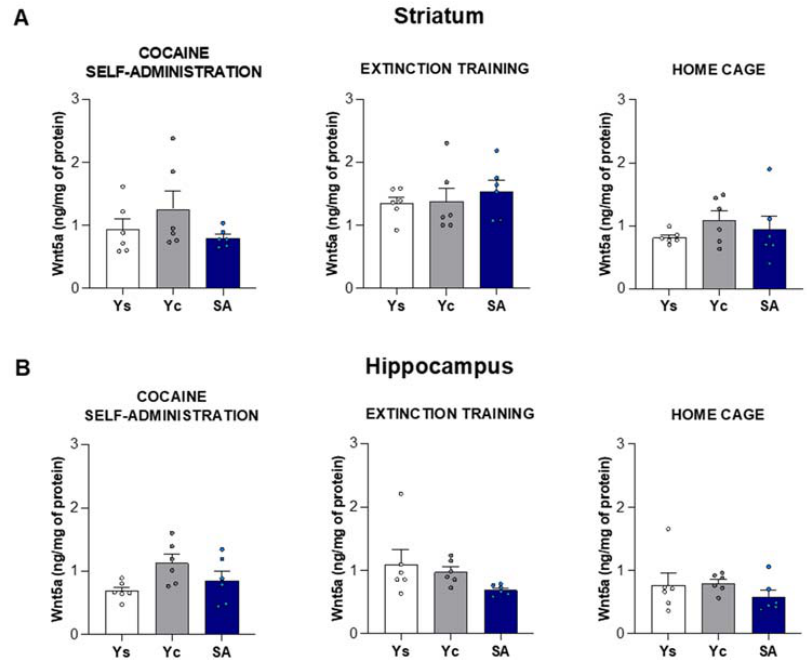
Figure 5. The protein level of Wnt5a in the striatum ( A ) and hippocampus ( B ) after 14 days of cocaine self-administration (0.5 mg/kg/inf.) and 3 days of extinction training or cocaine abstinence in the home cage. n = 6 rats/group. Significance was determined using a one-way ANOVA. SA: cocaine self-administration group; Yc: yoked cocaine group; Ys: yoked saline control group.